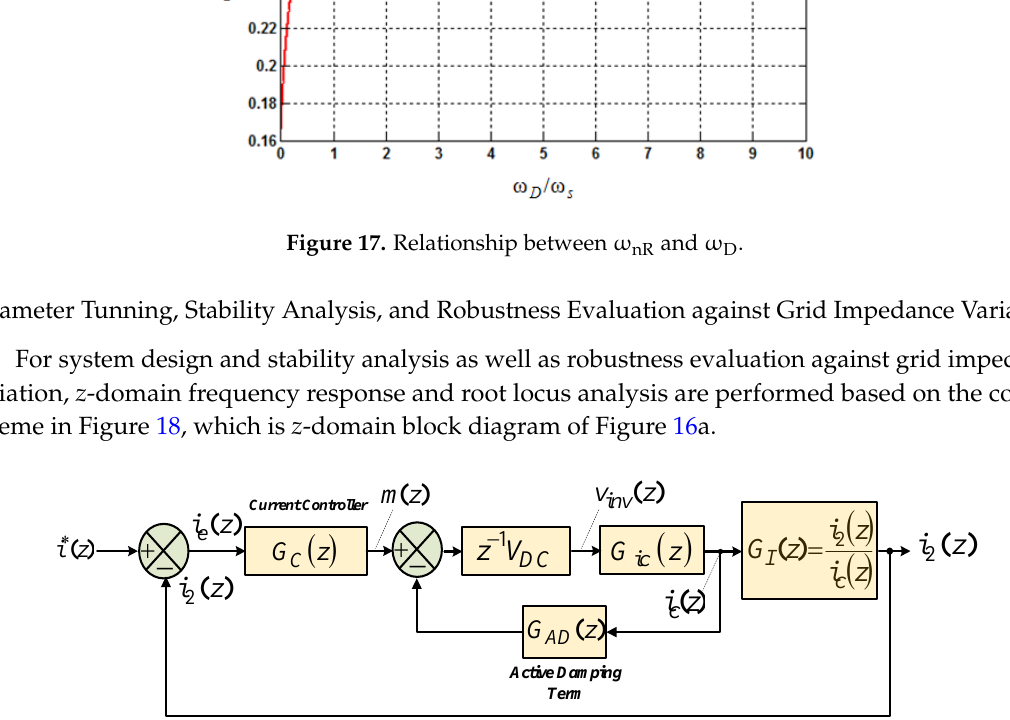
Figure 18. Z -domain block diagram of the first-order HPF-based CCF AD scheme.